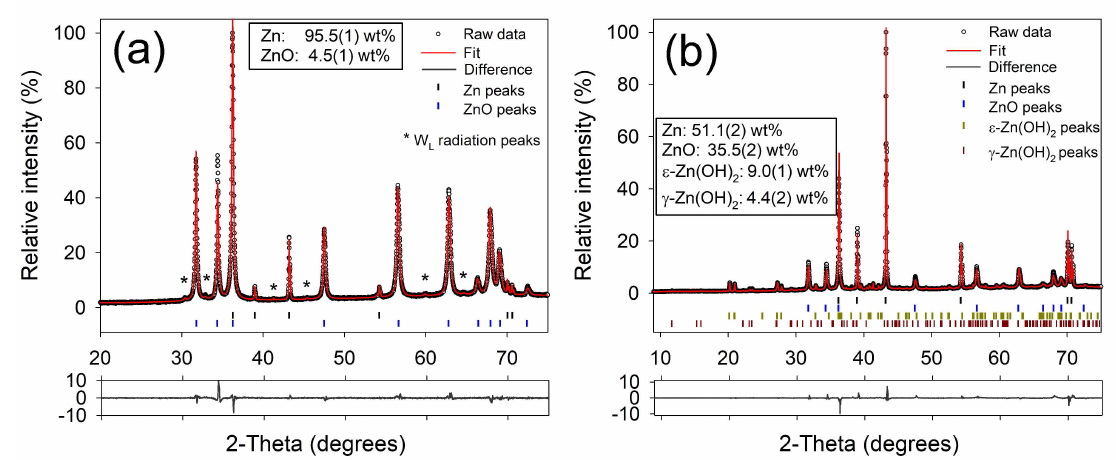
Figure 6. Fitted X-ray diffractograms of ( a ) a cold-sintered porous Zn electrode after discharge (corresponding to the electrode shown in Figure 5) ( b ) a cold-sintered porous Zn electrode after 152 h of ZAB cycling, finishing on a charge